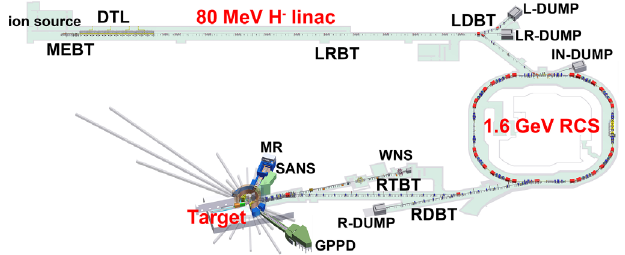
FIG. 1. The schematic layout of accelerator and target in CSNS.